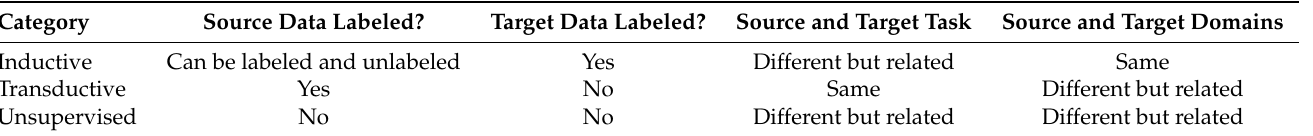
Table 1. Taxonomy of transfer learning depending on data, task, and domain of source and tar- get models.